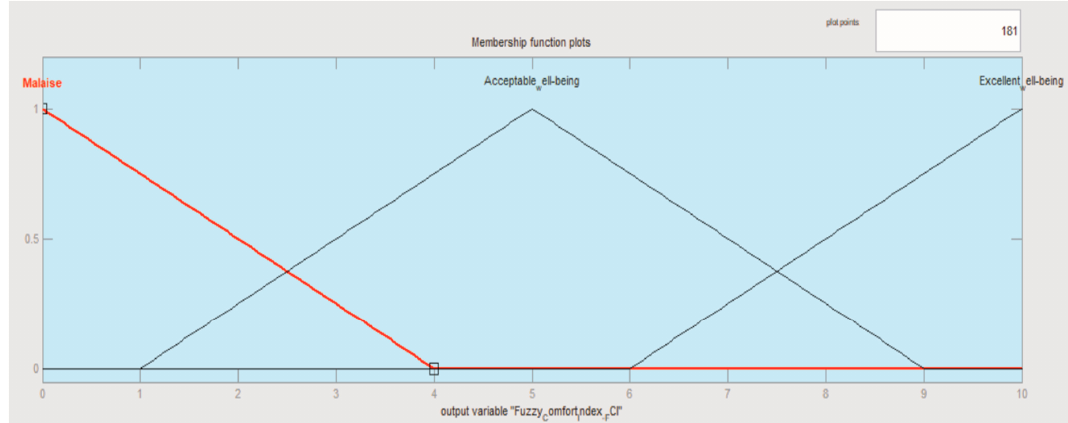
Figure 8. Fuzzy Comfort Index sets.